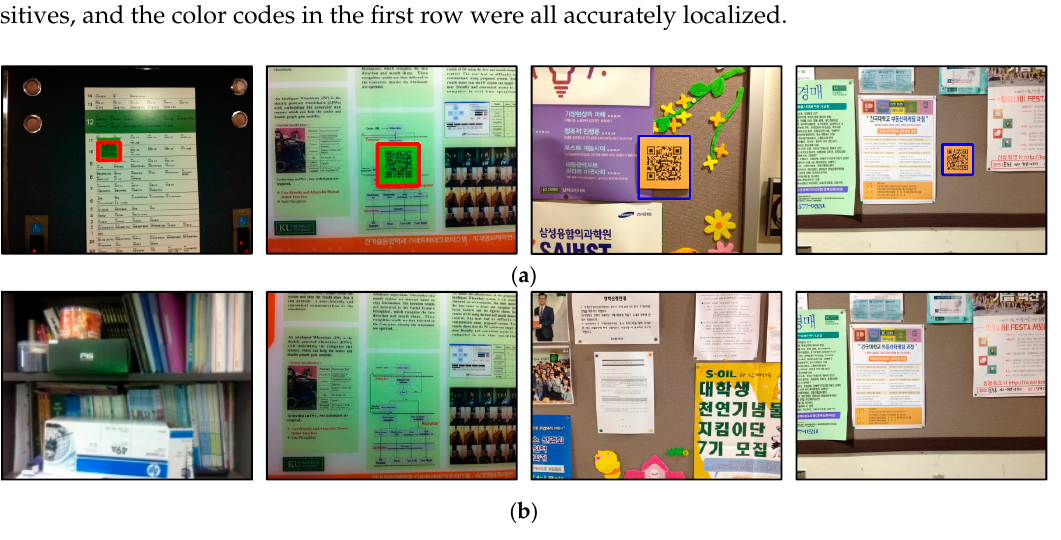
Figure 14. QR code localization results on complex scenes: ( a ) Images include QR codes; ( b ) Images without QR codes.